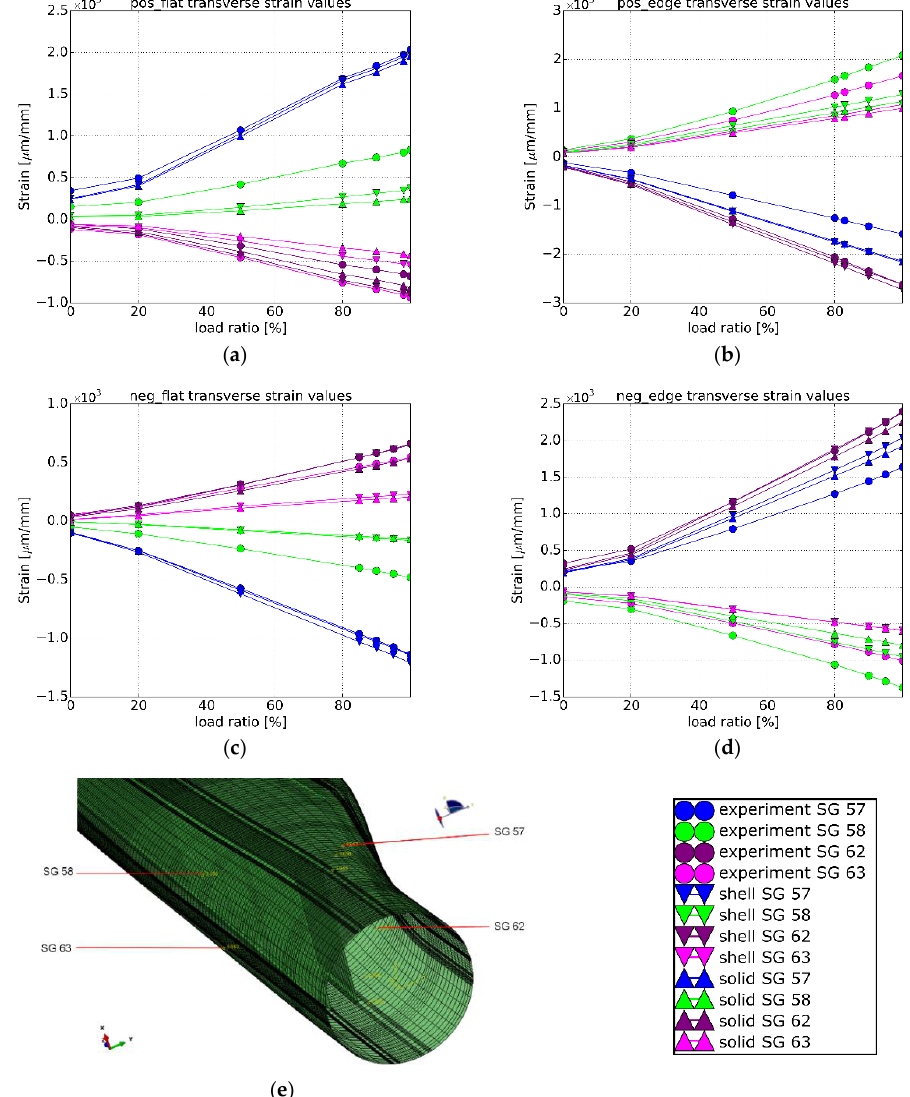
Figure 14. Overview of the transverse true strain values at the different strain gauge locations. ( a ) Positive flatwise load case; ( b ) positive edgewise load case; ( c ) negative flatwise load case; ( d ) negative edgewise load case; ( e ) overview of the locations of the strain gauges.